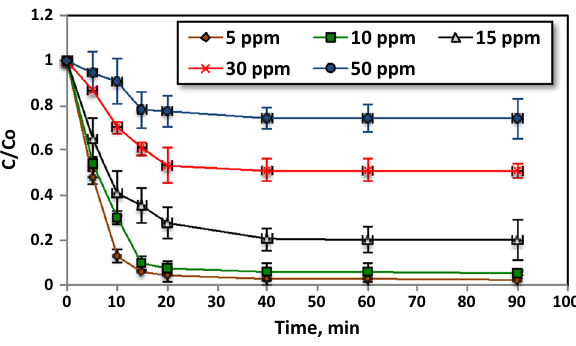
Fig. 3 Effect of initial MB dye concentration on the photodegradation